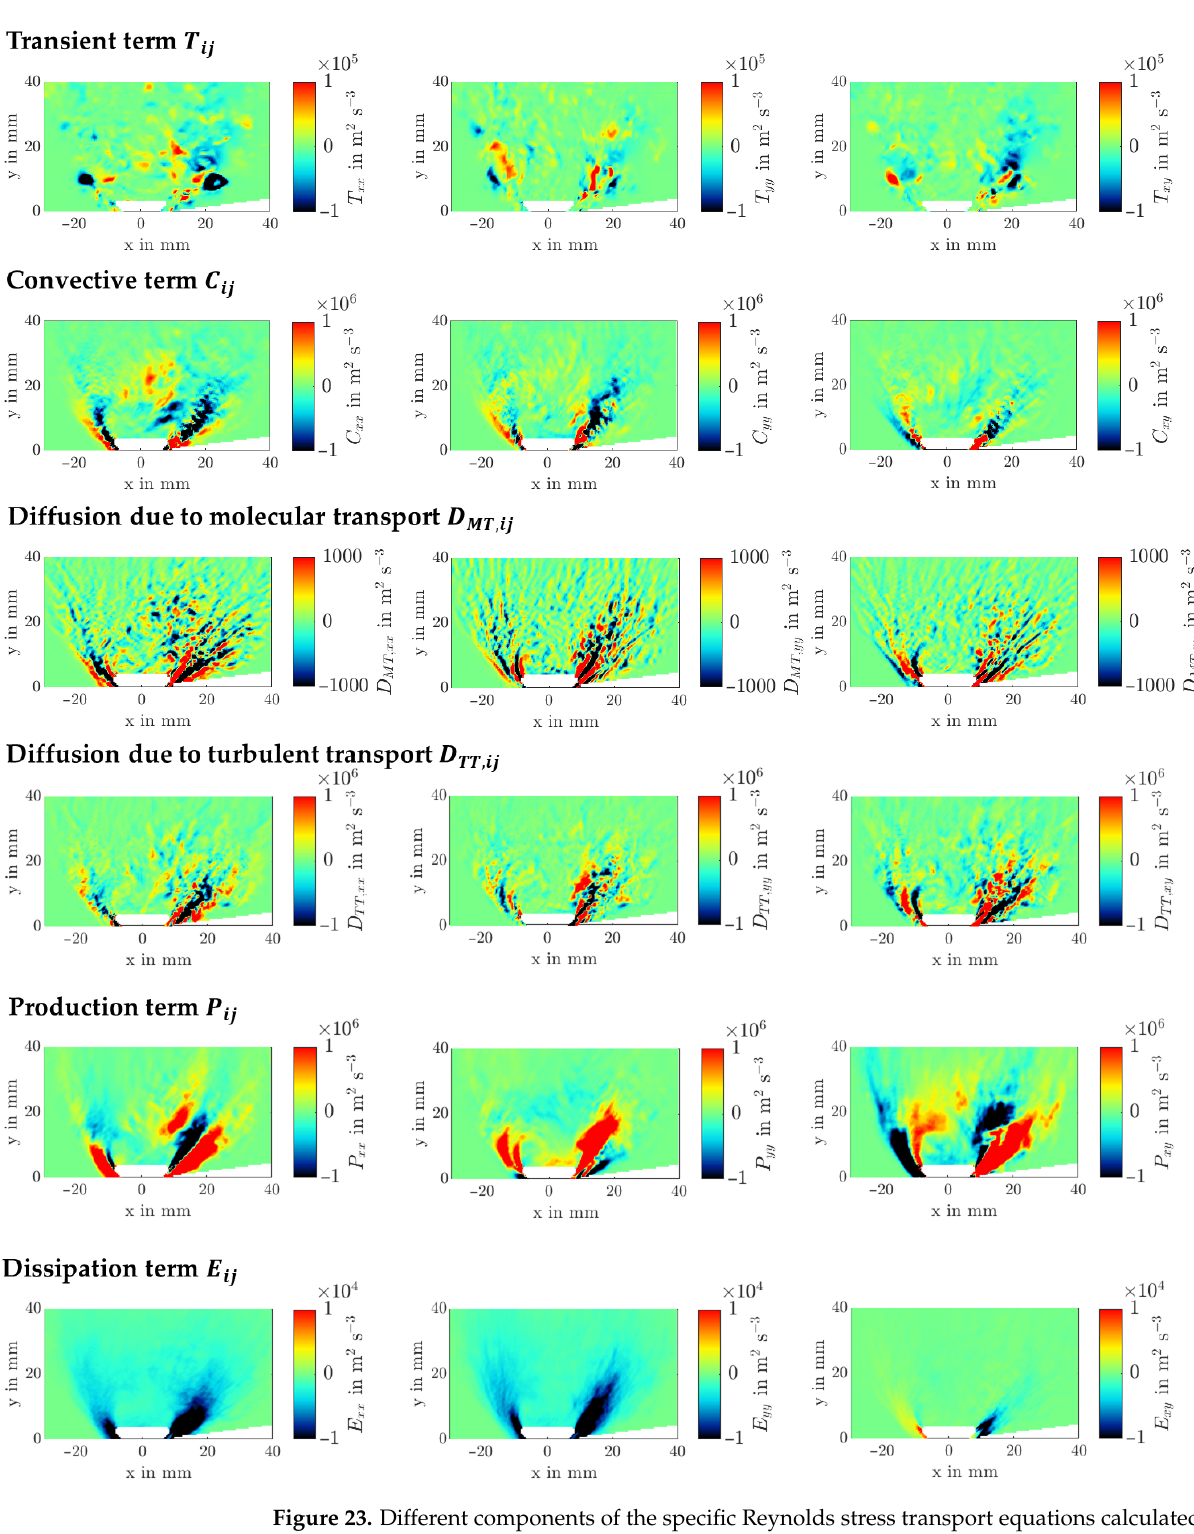
Figure 23. Different components of the specific Reynolds stress transport equations calculated from LES results at 4 mm and 39.6 kg/h, components of xx, yy, and xy from left to right (terms involving third dimension zu z are set to zero).